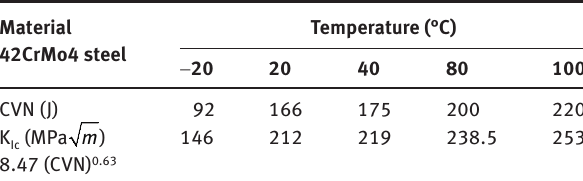
Table 3: Charpy V-notch impact energy and fracture toughness